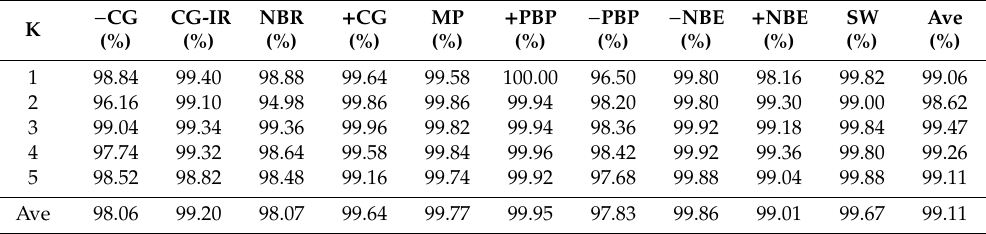
Table 2. Five-fold cross-validation for di ff erent types of classification